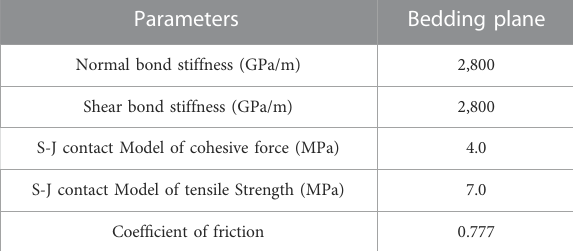
TABLE 5 Calibration results of bedding plane